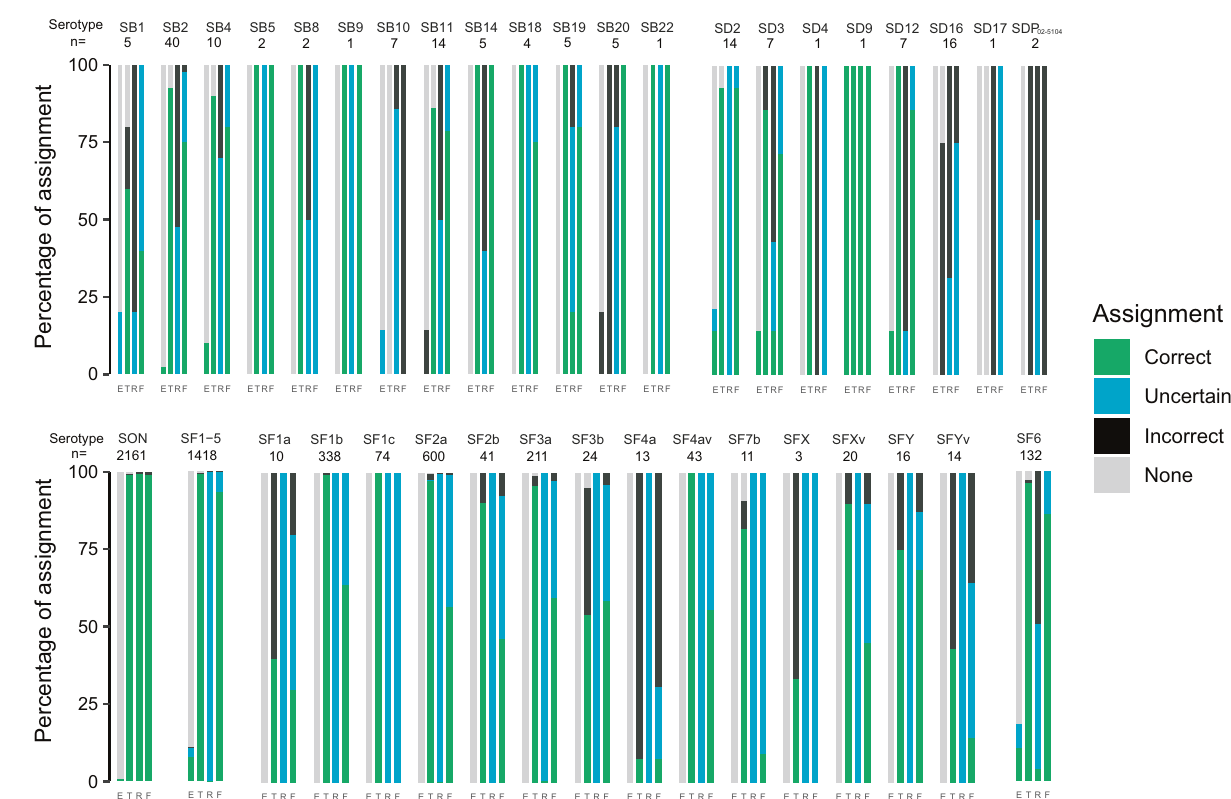
Fig. 9 Graphical representation of the in silico serotyping results for 3861 Shigella “ routine ” isolates according to each serotype prediction tool. Stacked-bar chart displaying the results (percentage assignment) per tool for each Shigella serotype. E, the SeroPred tool implemented in EnteroBase 18 ; T, ShigaTyper 14 ; R, ShigEiFinder 16 using short reads; F, ShigEiFinder using SPAdes assemblies. SB S. boydii , SD S. dysenteriae , SON S. sonnei , SF S. fl exneri . A correct assignment means that the predicted serotype was the same as the phenotypically determined serotype. An uncertain assignment means that the correct serotype was listed among others or for ShigEiFinder that only the cluster level (Cs1 to Cs3) was obtained. An incorrect assignment means that the predicted serotype was different from the phenotypically determined serotype. “ None ” means that no serotype was predicted. More detailed results can be found in Supplementary Table